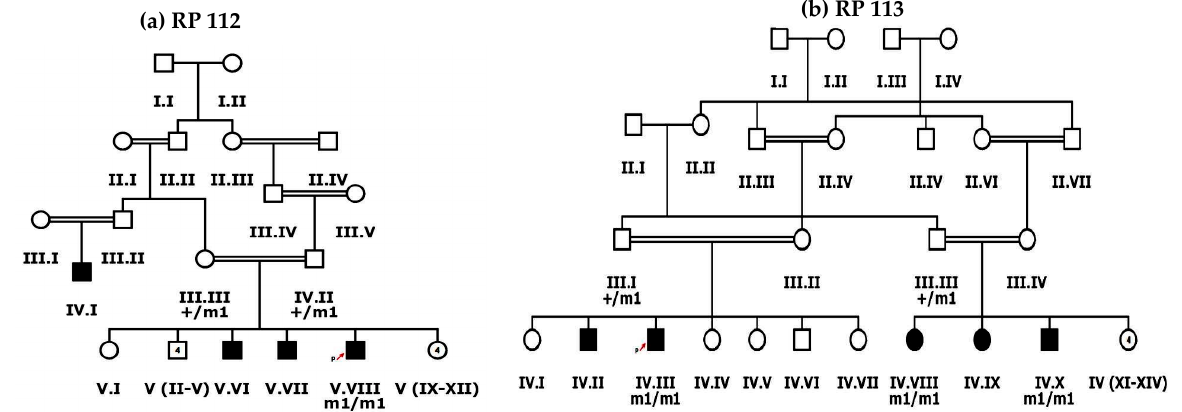
Figure 2. Pedigree drawings of inherited retinal dystrophies families, i.e., ( a ) RP112 and ( b ) RP113 showing autosomal recessive pattern of phenotype in which the novel disease-causing variant in the SPATA7 gene was detected. Squares and circles denote males and females, respectively. Filled symbols show affected, while unfilled symbols show unaffected individuals. Double lines indicate consanguineous union. m1/m1 refers to the homozygous disease-causing variant, whereas m1/+ refers to heterozygous carrier status.